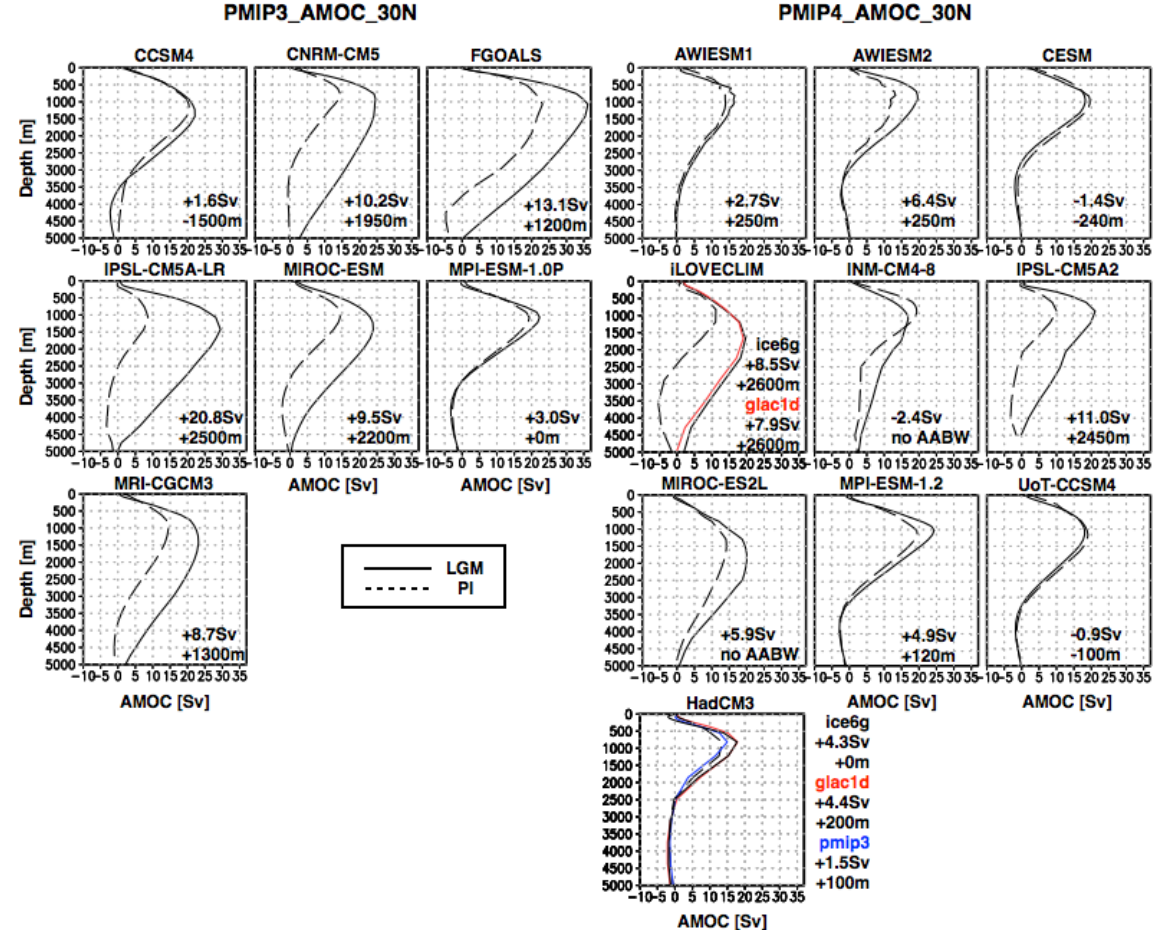
Figure 4. Mean Atlantic Meridional Overturning Circulation (mean meridional stream function for the Atlantic Ocean at 30 ◦ N) simulated by the PMIP3 and PMIP4 models for PI and LGM. Numbers in Sv indicate the LGM–PI anomaly in terms of maximum Atlantic meridional overturning streamfunction. Numbers in metres indicate the LGM–PI anomaly in terms of NADW vertical extension, the NADW vertical extent being defined here as the depths over which the mean meridional stream function for the Atlantic Ocean at 30 ◦ N is